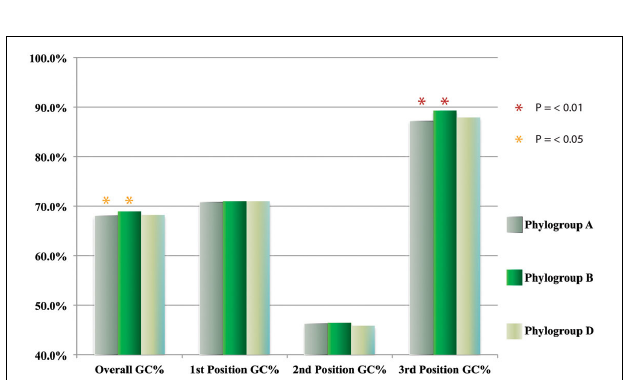
FIGURE 3 | Average Nucleotide Identity (ANI) and tetramer frequency correlation analysis. Color coding reflects three described ANI cutoffs for species delineation. Red squares represent ANI values of 96% or